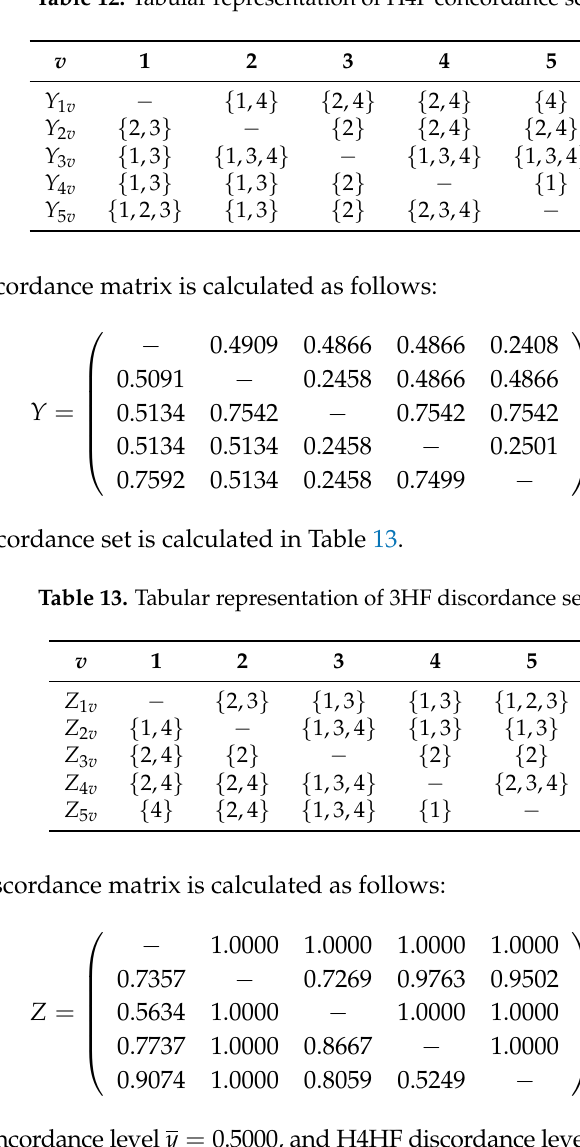
Table 12. Tabular representation of H4F concordance set.